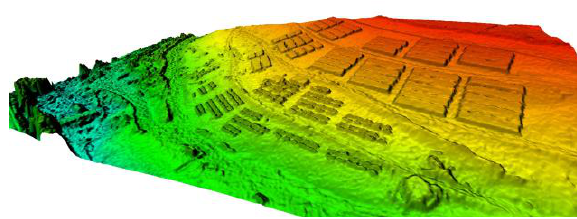
Figure 11 Southwest side of DSM with solar panels